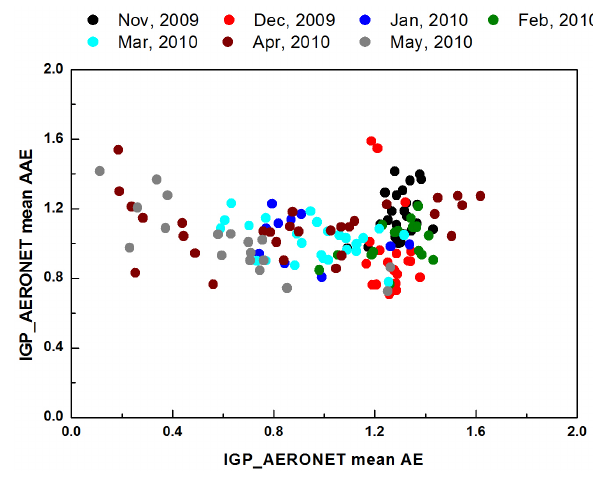
Fig. 15. Scatter plot of IGP AERONET daily mean Angstrom ex- ponent of AOD (AE) and daily mean Angstrom exponent of AAOD (AAE) for the IGP region. IGP AERONET was calculated from the mean of six AERONET sites located in India and Nepal (see Fig.